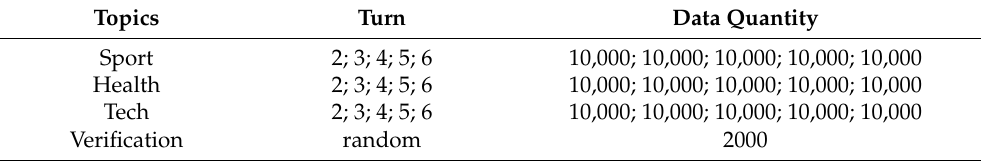
Table 3. Statistics of conversation data on fixed topics.